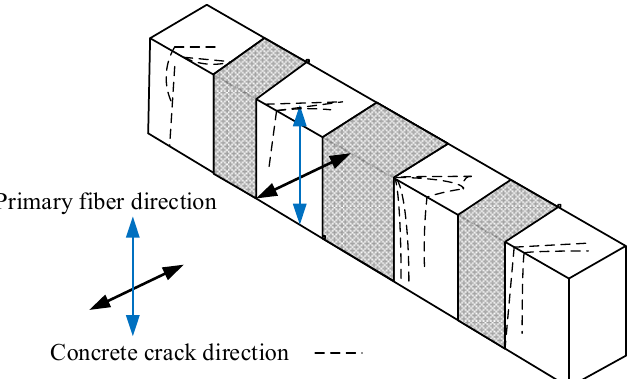
Figure 7. The fracture mechanism of beams with repaired one-layer four-sided wrapping configu- rations and different fiber